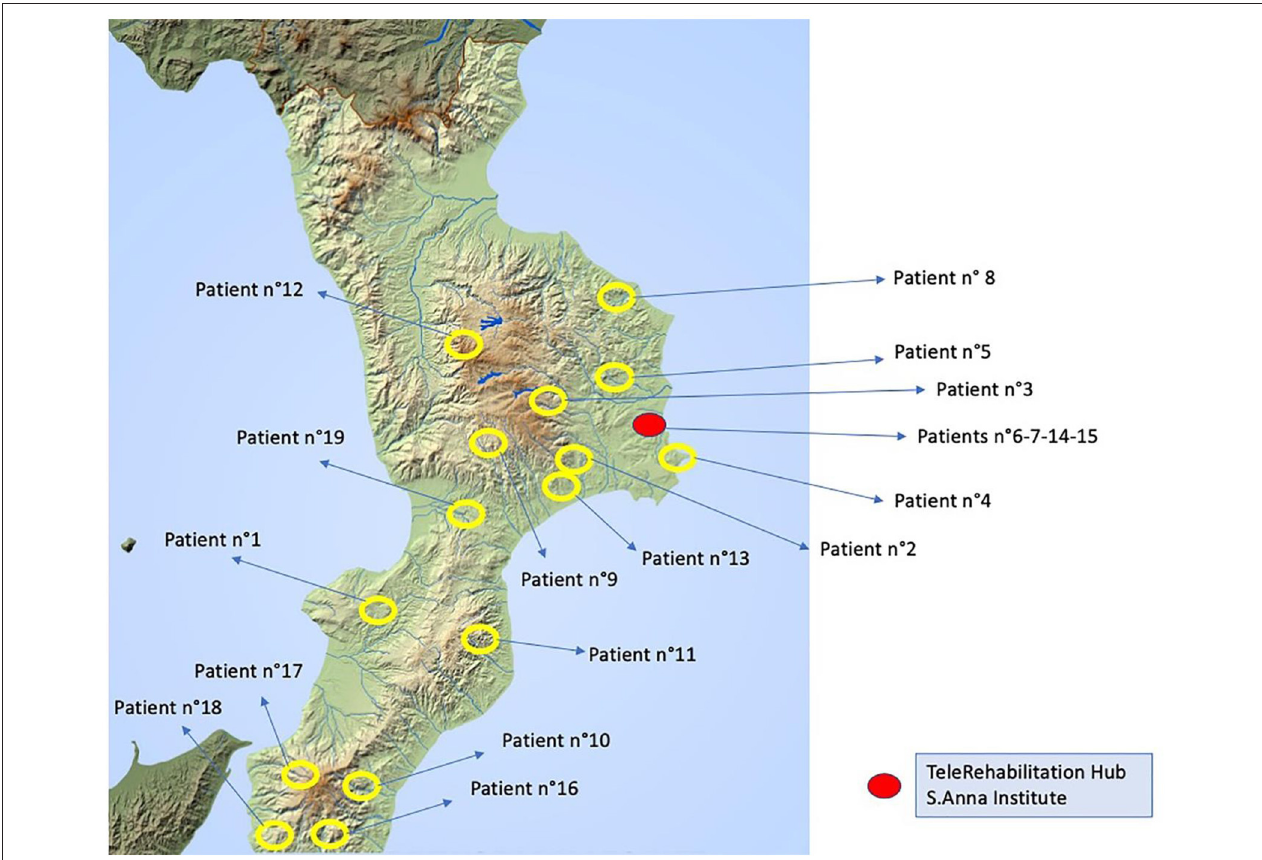
FIGURE 3 | Physical map of the Calabria region showing patients’ localizations during TR treatment.